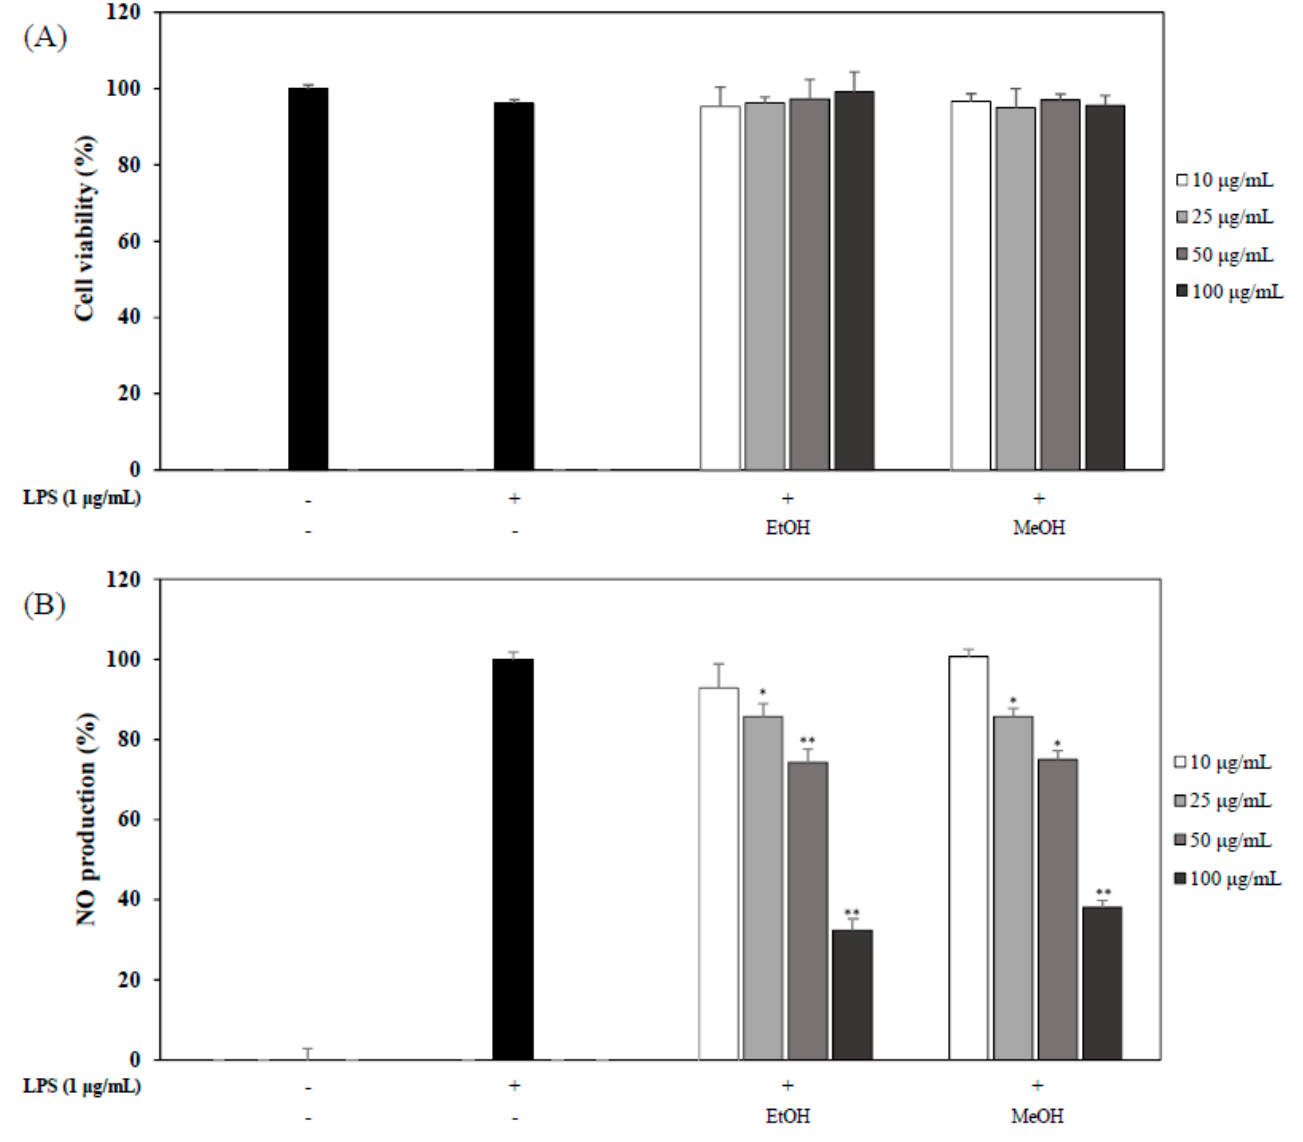
Figure 4. Effects of OP OFLE and MeOH OFLE on cell viability and NO production. Inhibitory effects of OP OFLE and MeOH OFLE (10, 25, 50, and 100 μ g/mL) on cell viability and NO production of LPS-stimulated RAW 264.7 cells were determined. Cells were pretreated with each extract at different concentrations for 20 h. Cytotoxicity ( A ) was determined by MTT assay. Culture media were used to determine NO production ( B ) with Griess reagent. Data are represented as mean ± SD. * p < 0.05, ** p < 0.01 vs. LPS-treated group.